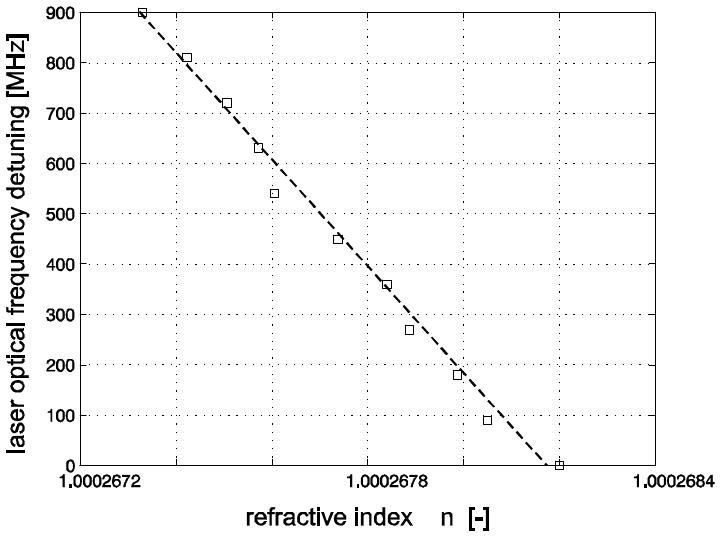
Figure 6. Recording of the refractive index drift and associated laser frequency tuning following the zero sum of the both interferometers